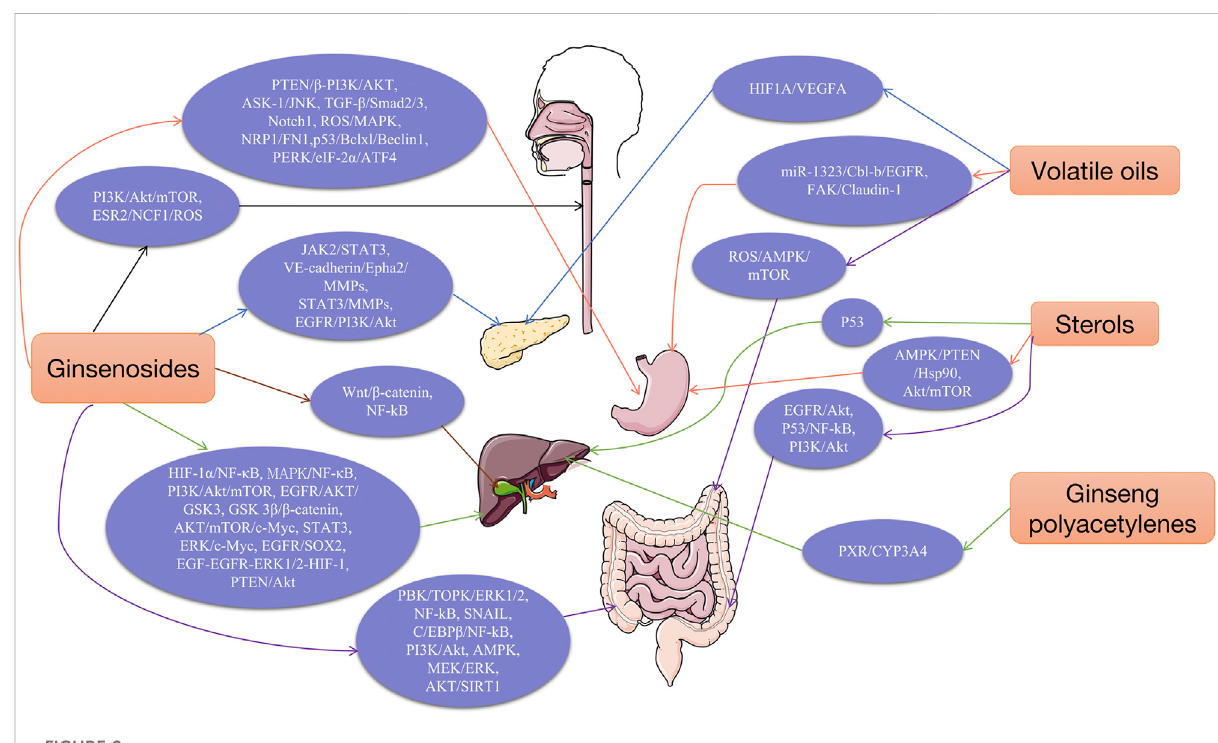
FIGURE 2 Molecular mechanism/pathway of the anti-tumor effects of